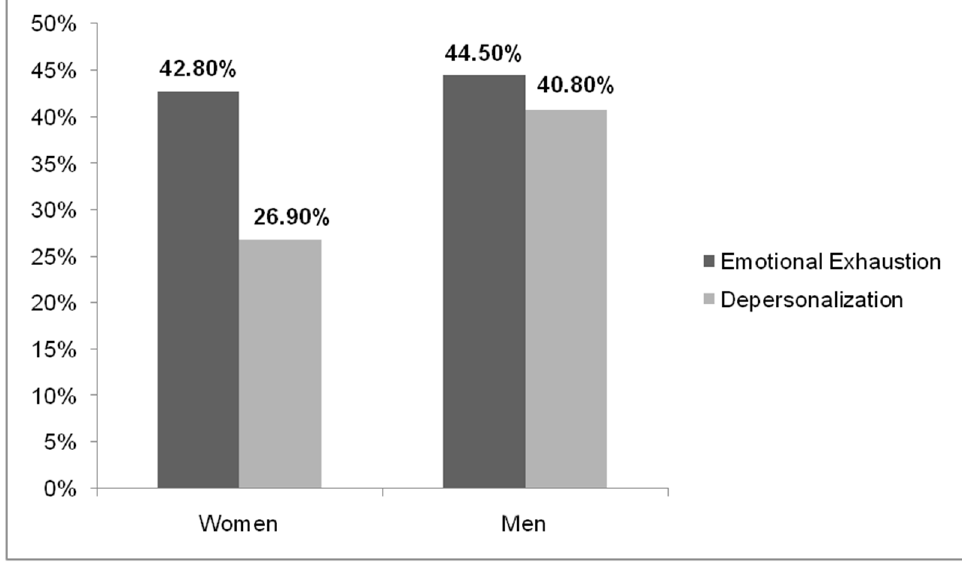
Figure 2. Percentages of emotional exhaustion and depersonalization in women and men.